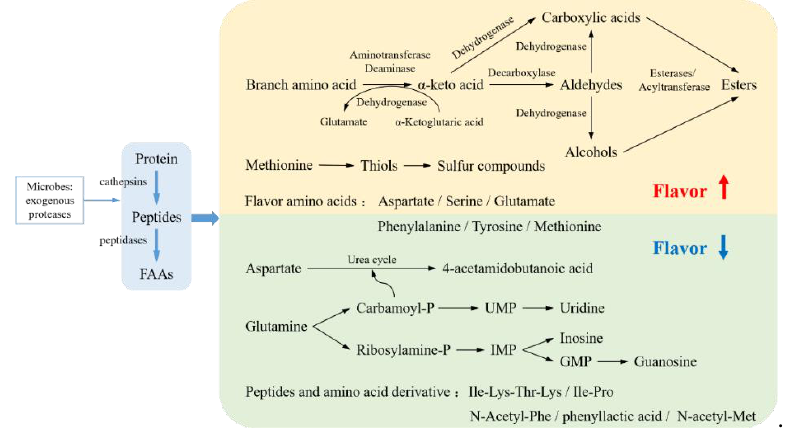
Figure 3. Effects of Protein Degradation on the Flavor of Fermented Meats